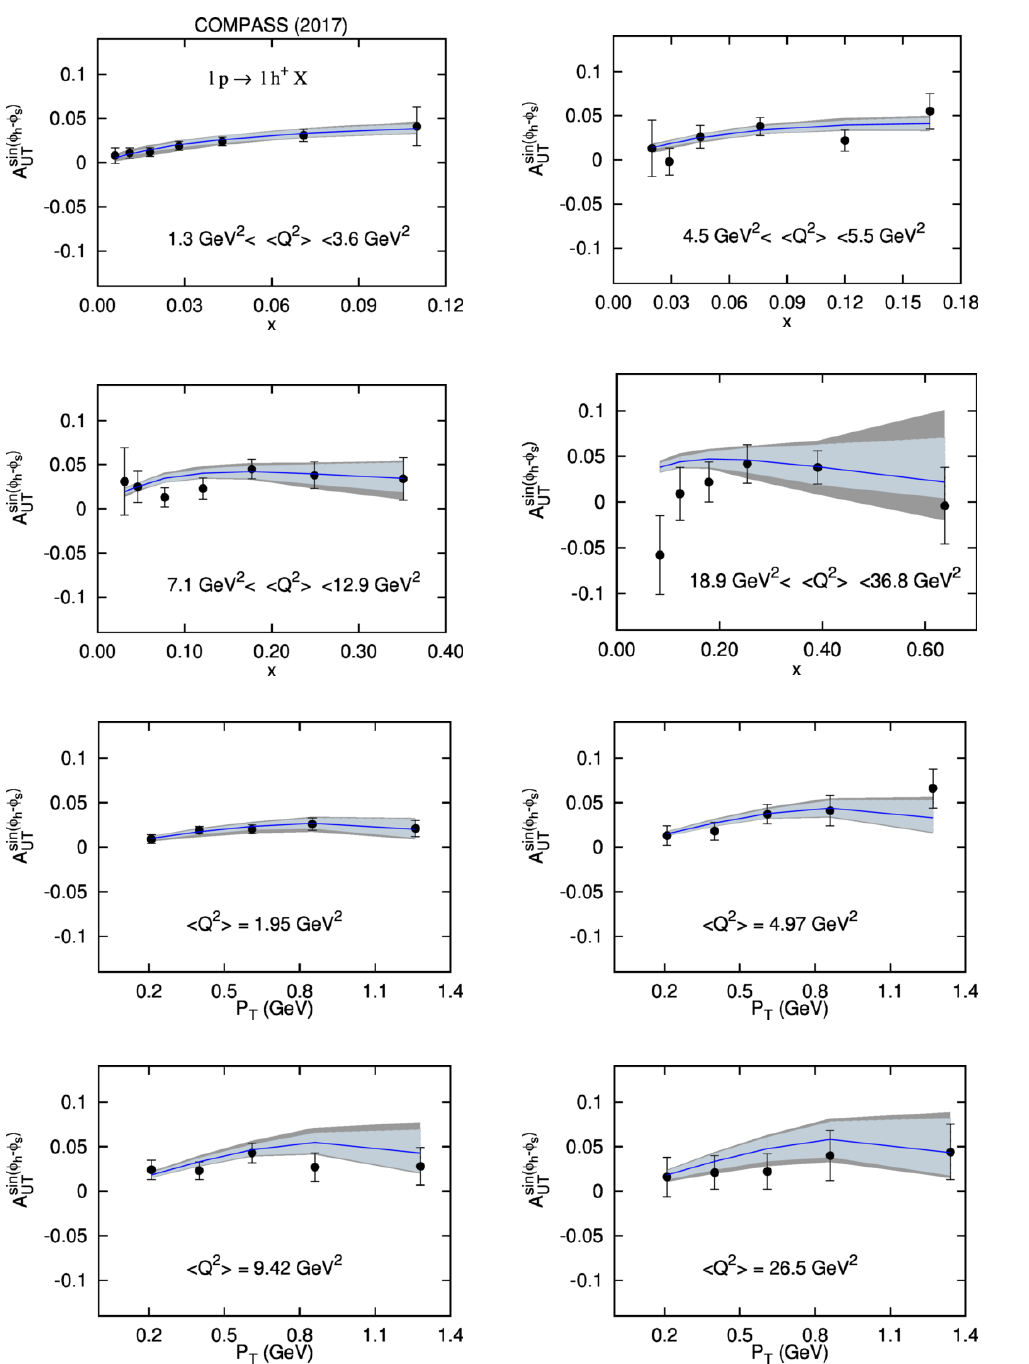
Figure 7 . The results obtained from the reference (cid:12)t and the (cid:11) -(cid:12)t are compared to the COMPASS Collaboration measurements of the SIDIS Sivers asymmetry on a NH 3 target [9] for h + production. We show the x and P T dependences, the z depedences are not included in the (cid:12)t. The shaded regions correspond to our estimate of 2 (cid:27) C.L. error band. The light-blue bands correspond to the uncertainties of the reference (cid:12)t (only N and (cid:12) free parameters), while the (larger) gray u ( d ) u ( d ) bands correspond to the uncertainties of the (cid:11) -(cid:12)t which includes also the (cid:11) parameters. u ( d )